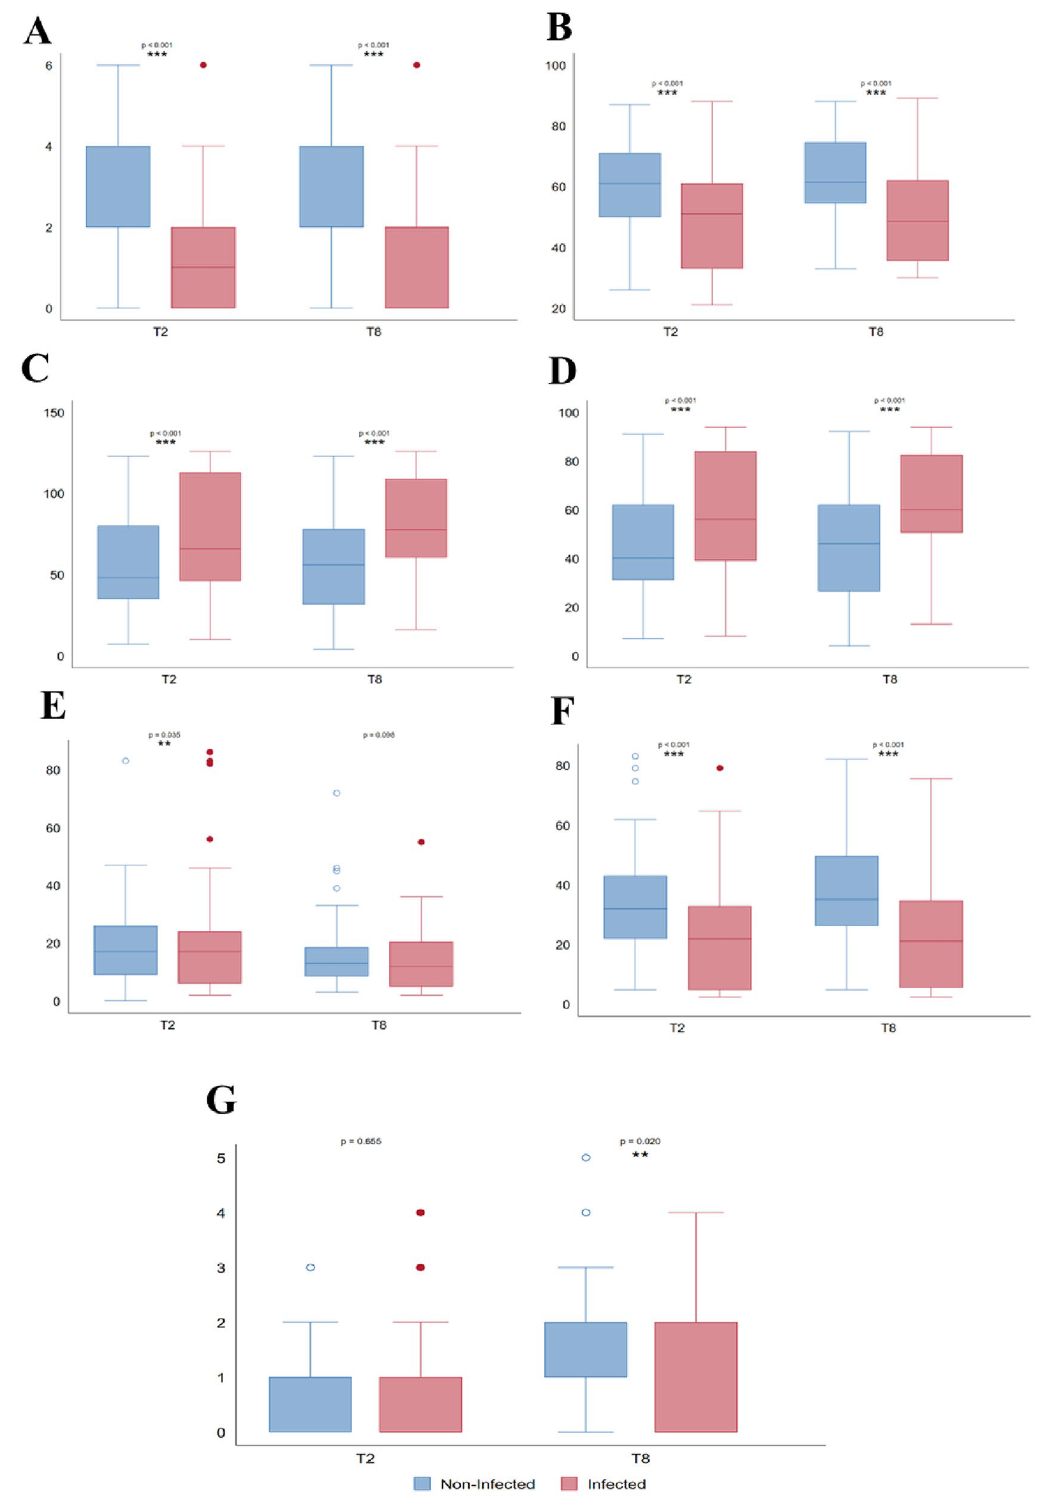
Figure 3. Executive performance assessed by WCST indicators. ( A ) Number of categories completed, ( B ) number total corrects ( C ) perseverative responses, ( D ) perseverative errors, ( E ) nonperseverative errors, ( F ) percent conceptual level responses and ( G ) failure to maintain